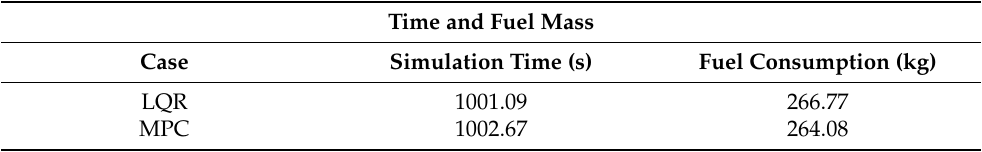
Table 2. Simulation time and fuel